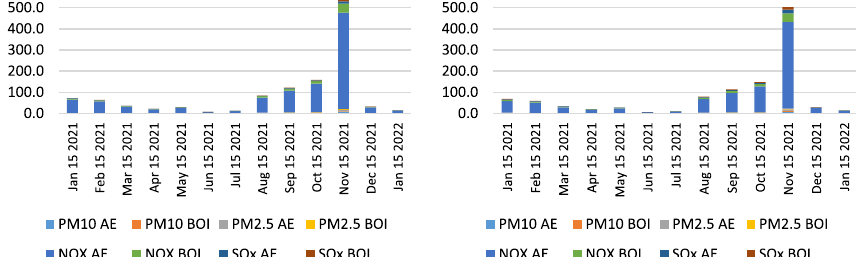
Fig. 13 Health‑related emission calculation of ships at anchorage area of the ports LA&LB based on energy and fuel‑based methodology (left) and Starcrest (right) excluding CO 2 in 2021 (in the average waiting time by